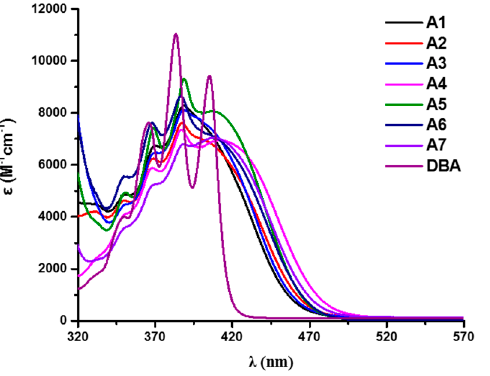
Figure 16. UV-visible absorption spectra of A1–A7 in acetonitrile. Reproduced with permission of Ref. [148]. Table 5. Optical characteristics of A1–A7 in acetonitrile. Data extracted from Ref.